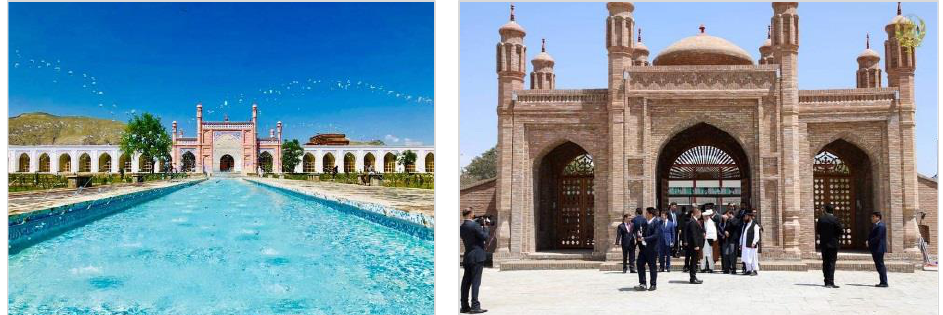
Figure 8 Current views of Id Gag Mosque after restoration (shafaqna,